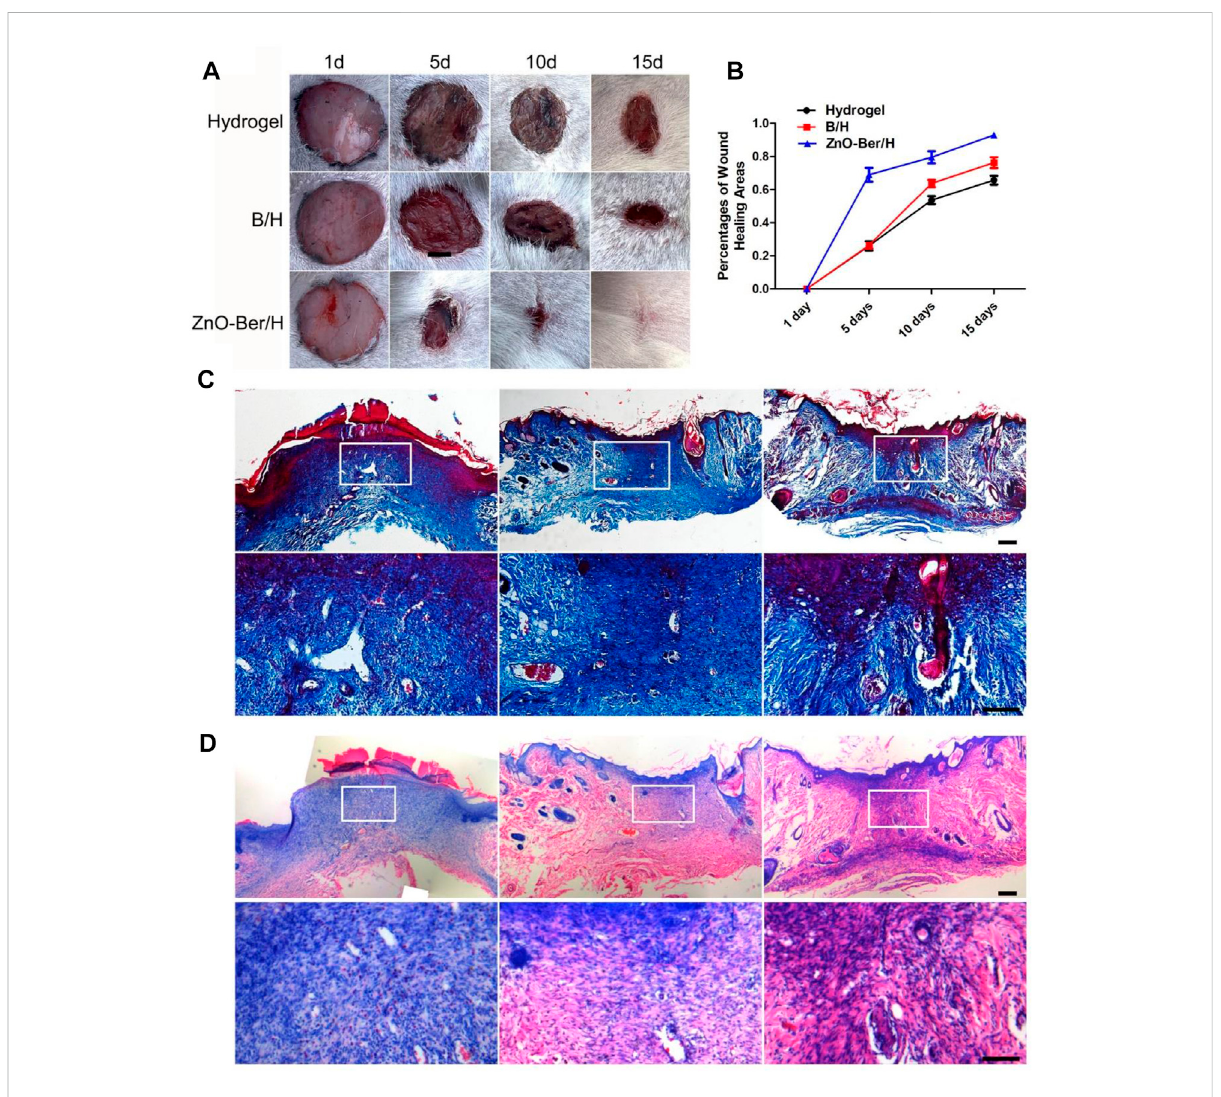
FIGURE 5 Histological staining of wound site. (A) General images of wounds after operation. (B) Wound closure rate analysis. (C – D) Masson and H&E staining and the partial magni fi cation of Masson and H&E staining. Scale bar: 100 μ m.